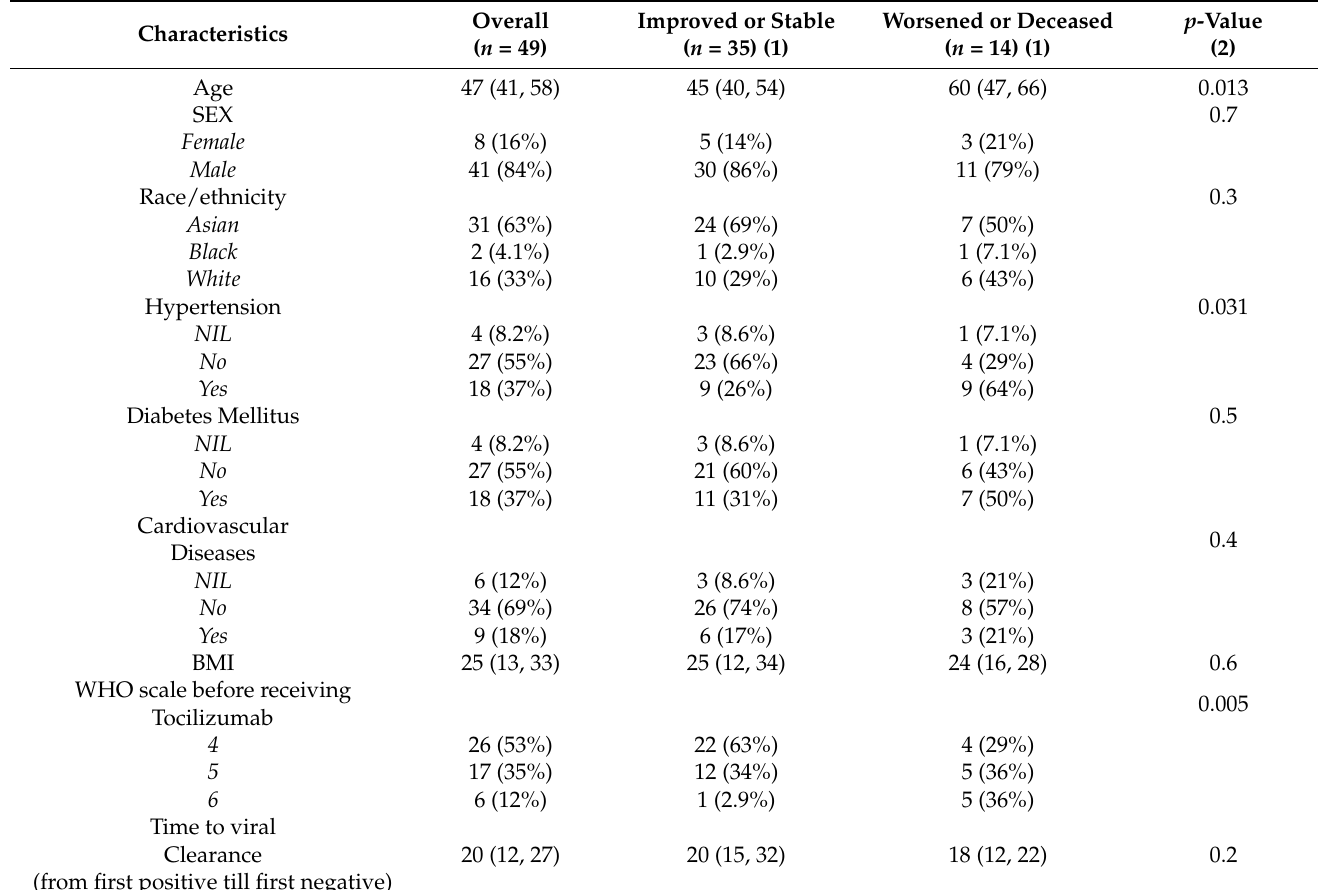
Table 1. Clinical characteristics of the patients.